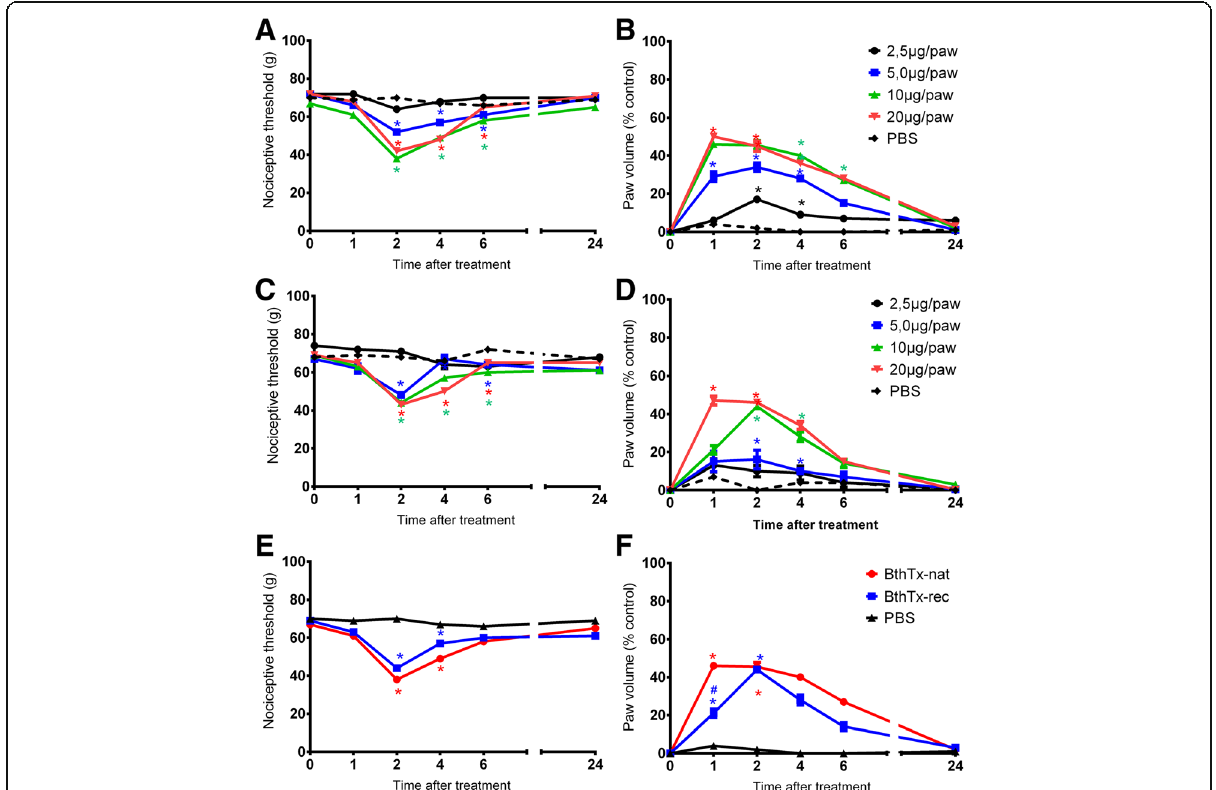
Fig. 1 Effect of native and recombinant bothropstoxin I injection on the pain threshold and paw volume. a Effect of the native-BthTx intraplantar injection on the pain threshold and b on paw volume, at different doses. c Effect of recombinant BthTx-I intraplantar injection on the pain threshold and d on paw volume, at different doses. e Comparison between native and recombinant BthTx-I hyperalgesic and f edematogenic effects. The pain threshold of the animals was determined in rat hind paw before at different times after the intraplantar injection of PBS (control group) or toxins. Sensitivity to pain was measured as the threshold response to pressure and expressed as g . The edema was determined by an increase in the volume in the right hind paw of rats compared with the control contralateral paw. The paw volume was obtained pletsmografically. Each point represents the mean ± SEM of six animals. *Significantly different from mean values before venom injection and #different from BthTx-I-recombinant (BthTx-I rec) ( p <